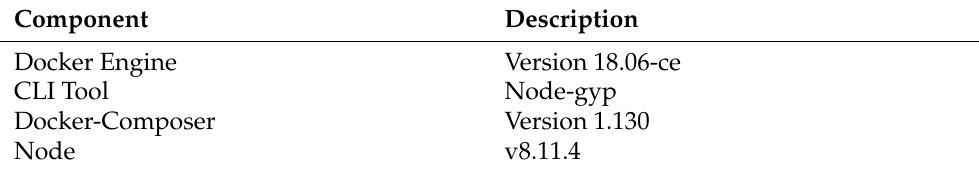
Table 11. Environmental Setup of Hyperledger Caliper.